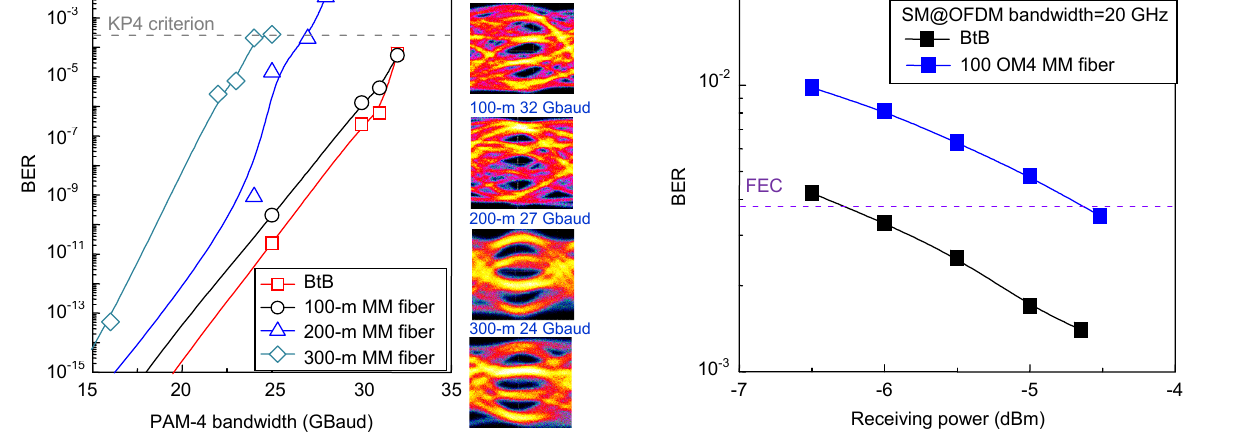
Fig. 9 | BERs of the SM VCSEL chip carried and data waveform pre-emphasized PAM-4 data at different bandwidths after BtB, 100-m, 200-m, and 300-m OM4 MMF transmissions with the corresponding eye-diagram.